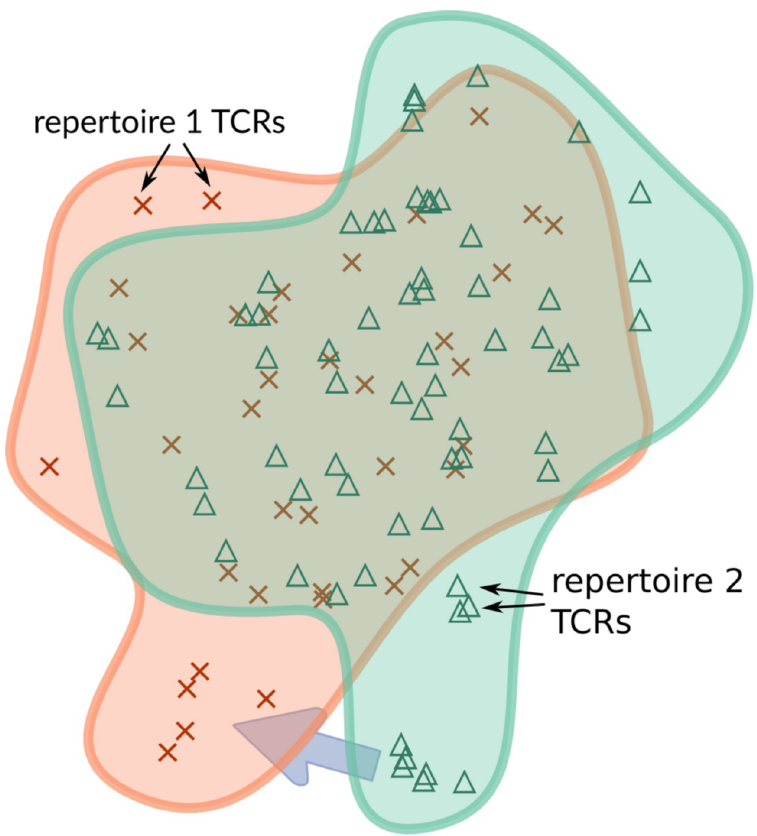
Fig 1. A schematic of TCR distribution comparison. Each symbol represents a TCR in an abstract space in which distance is defined via TCRdist [30], and the two regions represent two population repertoires of interest. Each repertoire is given its own color (here orange and green). The purple arrow shows that there are regions of these TCR distributions for the green repertoire that do not have a close equivalent in the orange repertoire, which will be identified by our optimal transport